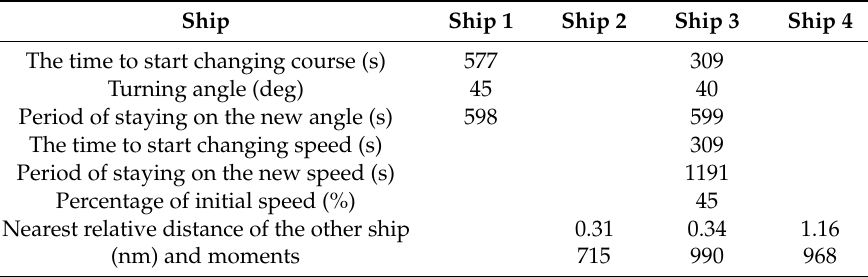
Table 4. Actions taken by each ship in scenario